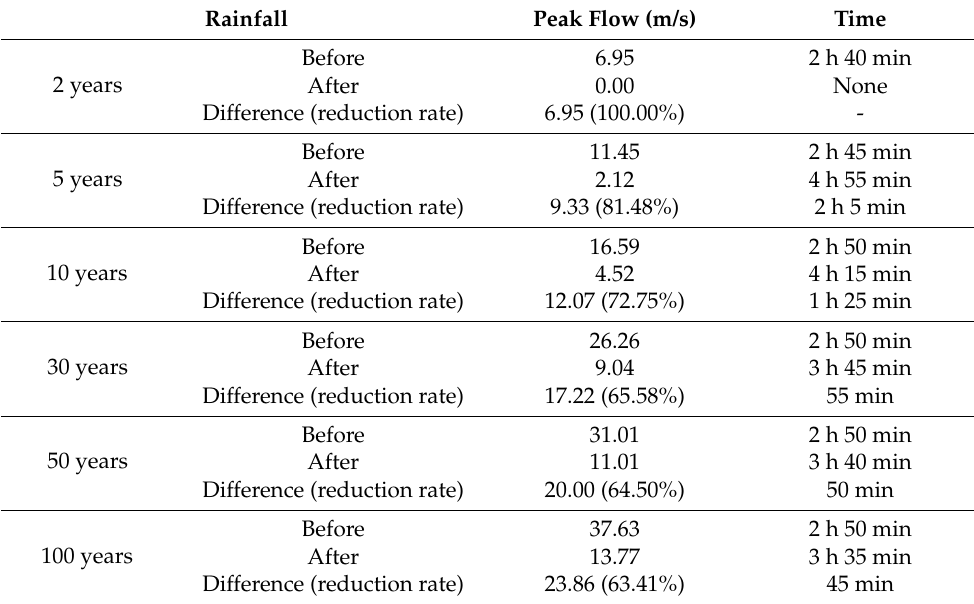
Table 3. Comparison of peak flow rate, peak reduction rate, and peak occurrence time of rainfall in different return periods before and after regional construction.